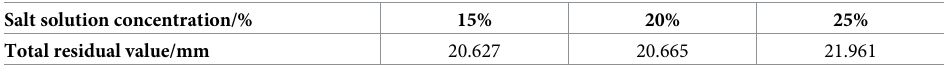
Table 12. Axial total residual deformation of reinforced concrete columns strengthened by SMA with different salt solution